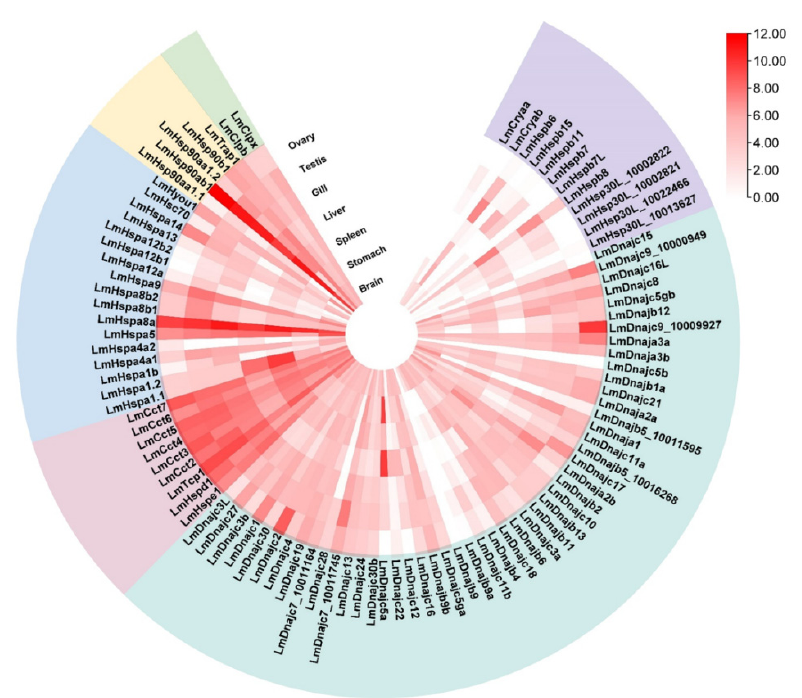
Figure 3. Expression profile of LmHsp genes among adult tissues of L. maculatus . The log 2 (FPKM + 1) values are represented as 0–12 according to the colored scale bar, and the heatmap is ranked with each LmHsp families.